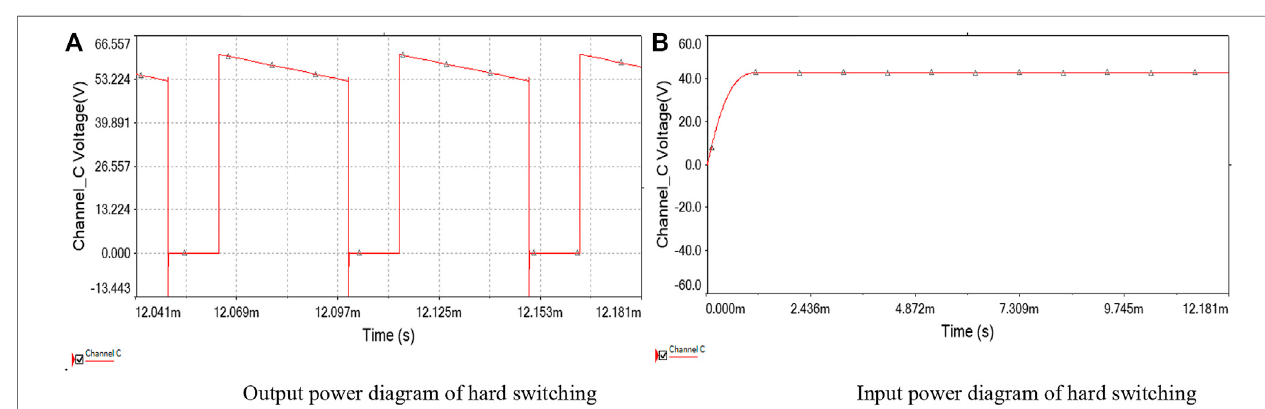
FIGURE 10 | Schematic diagram of hard and soft